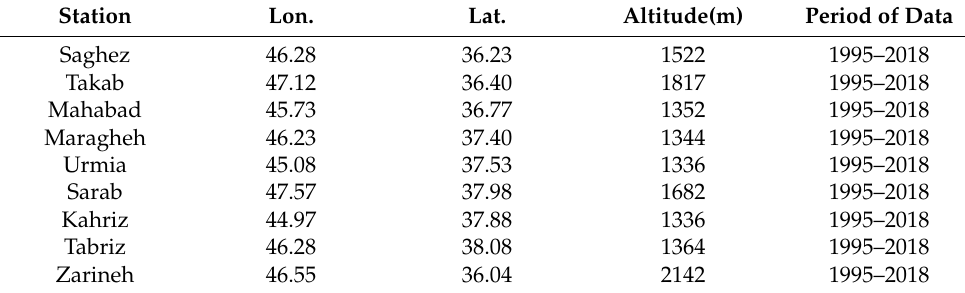
Table 1. Geographical characteristics of stations in the